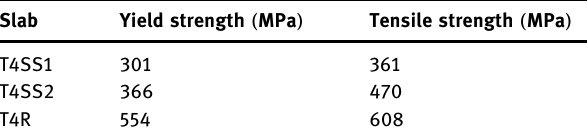
Table 1: Yield strength and tensile strength